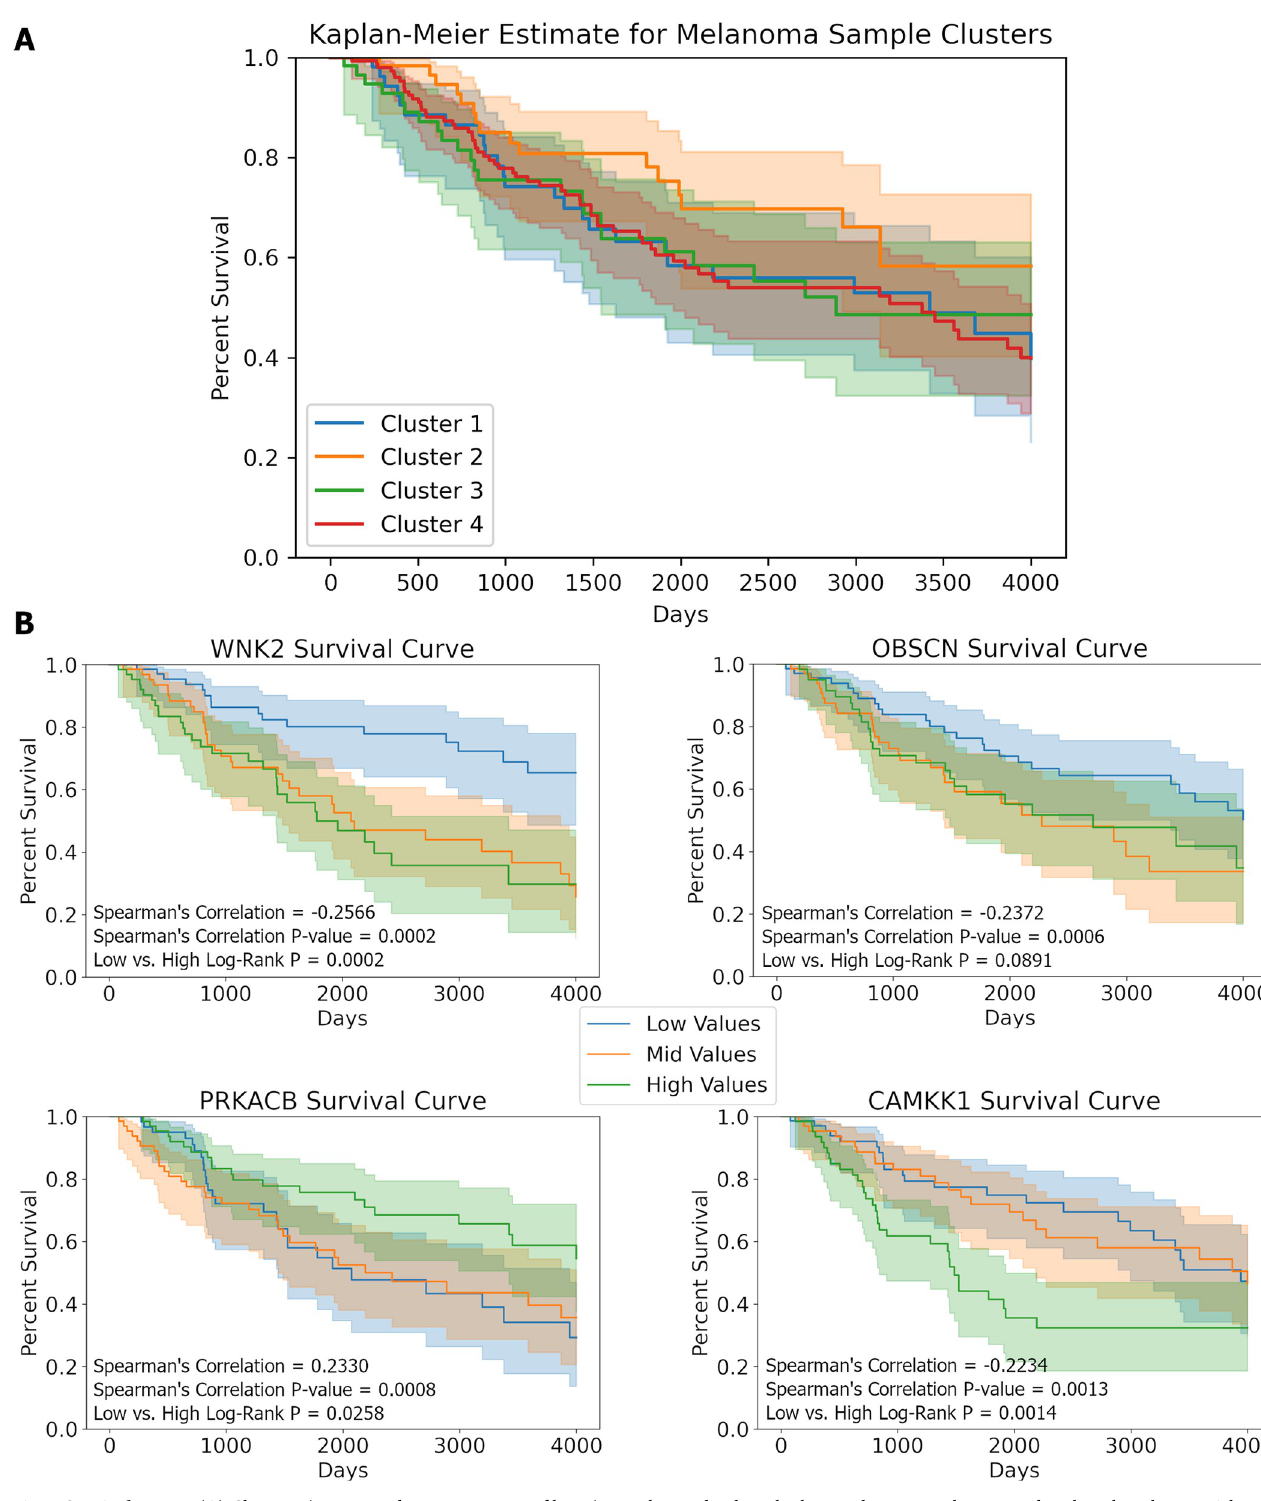
Fig 9. Survival curves. (A) Cluster 2 (corresponding to immune infiltrate) was observed to have higher median survival compared to the other clusters. A log- rank test comparing Cluster 2 survival against the rest of the samples showed a low level of statistical significance (p = 0.065). (B) Survival curves of the four genes with the highest Spearman correlation between gene expression and overall survival in high purity samples (n = 205). Samples were quantile binned by their gene count into low (blue), medium (red) and high (green) values. All survival curves were analyzed up to the 4000 days.